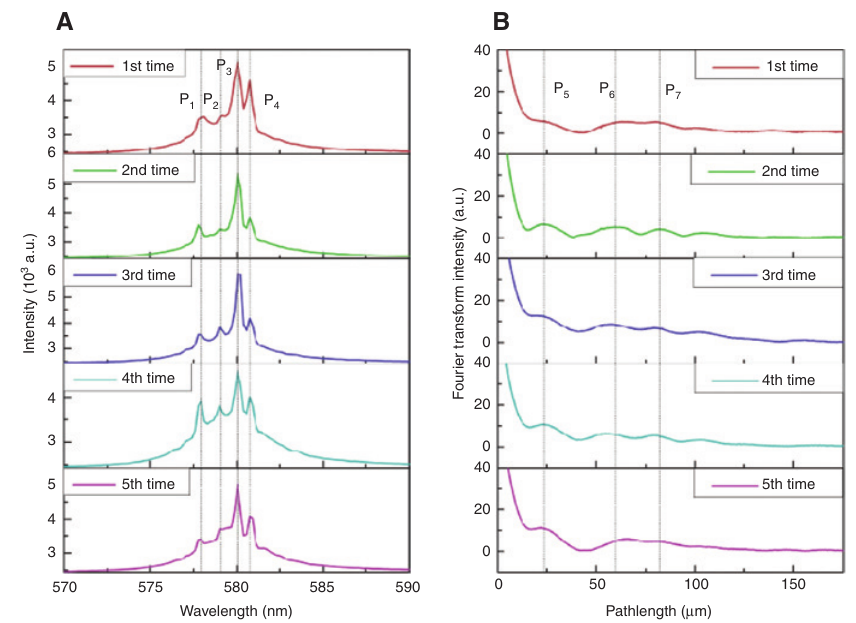
Figure 9: Spectral stability of random lasers observed in LOPP. The waterfall of LOPP with different reception time at the same pump energy ~ 350 μ J (A). The Fourier transform corresponding to the emis- sion spectrum of the LOPP with different reception time at the same pump energy ~ 350 μ J